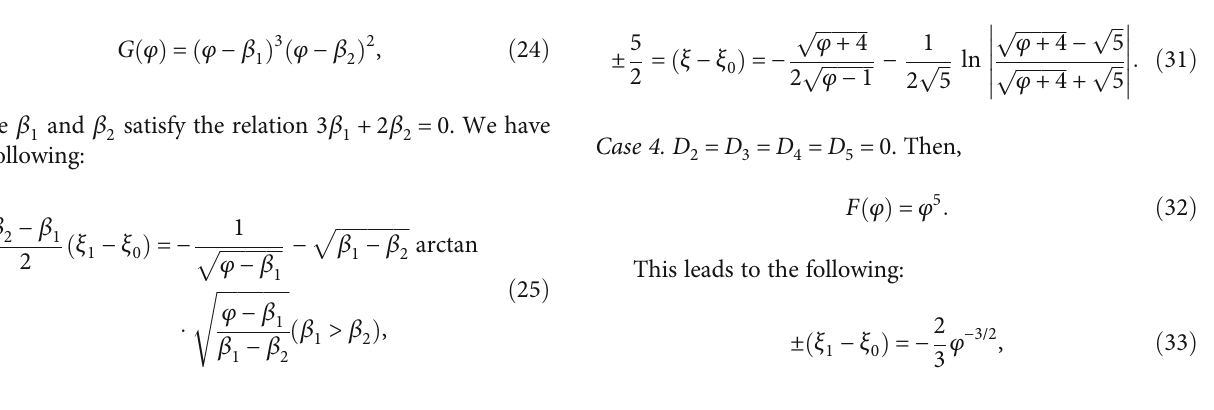
ffiffiffi p − 5 5